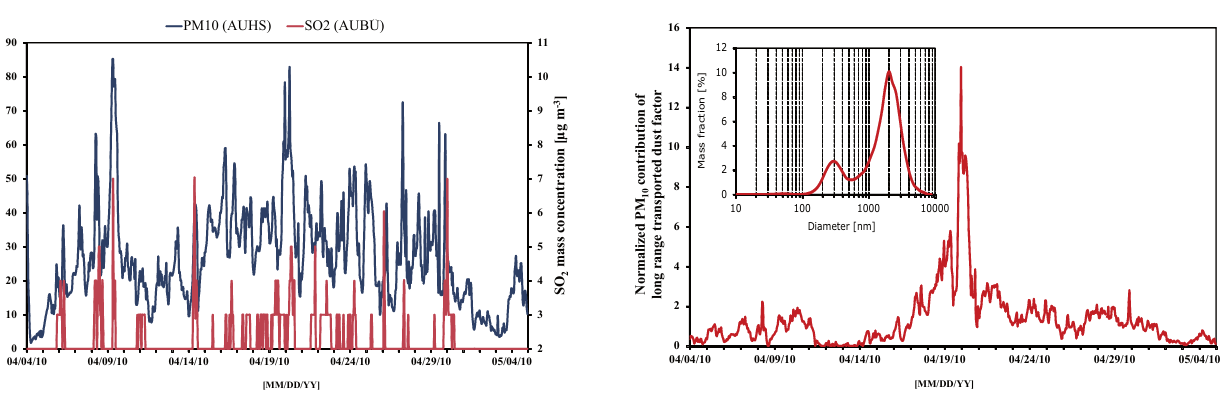
Fig. 1. Time series of hourly average PM 10 mass concentration measured at the University of Applied Sciences (AUHS) and SO 2 mass concentration measured at the Bavarian State Office for the Environment (AUB ¨U) in Augsburg, Germany.